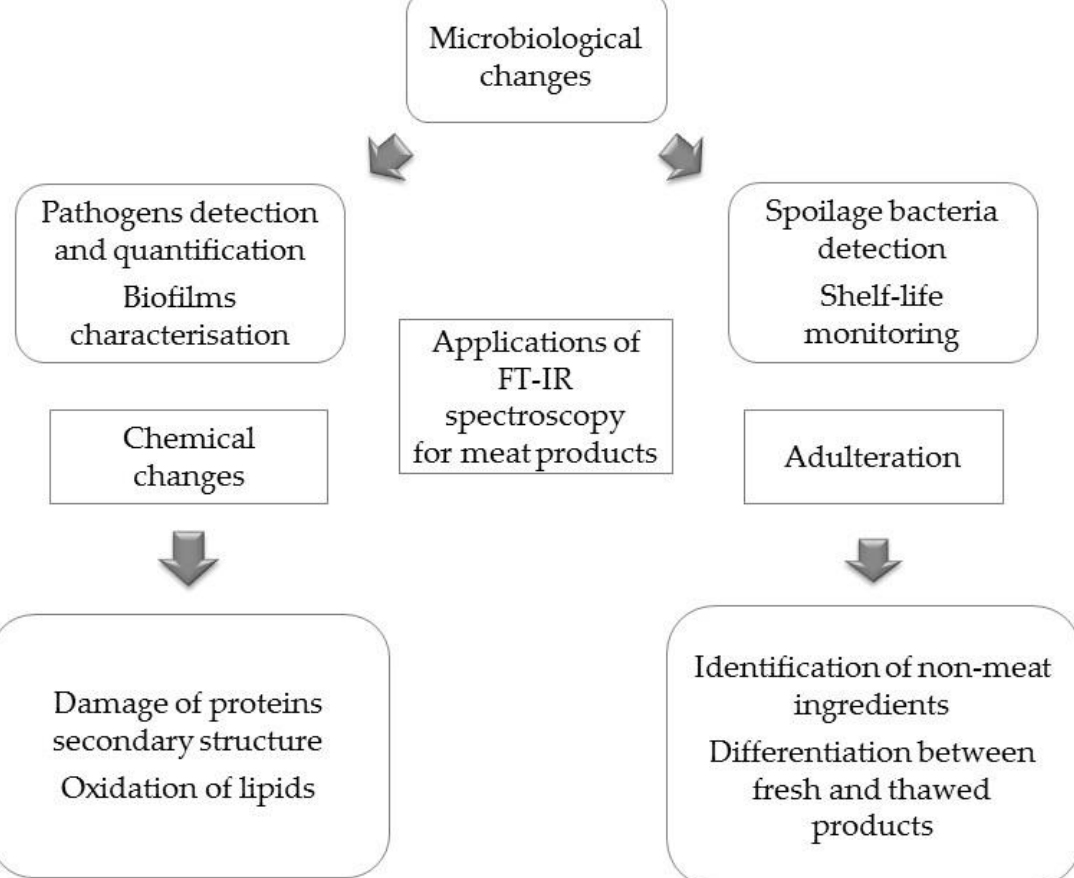
Figure 9. FT-IR spectroscopy applications for meat products.